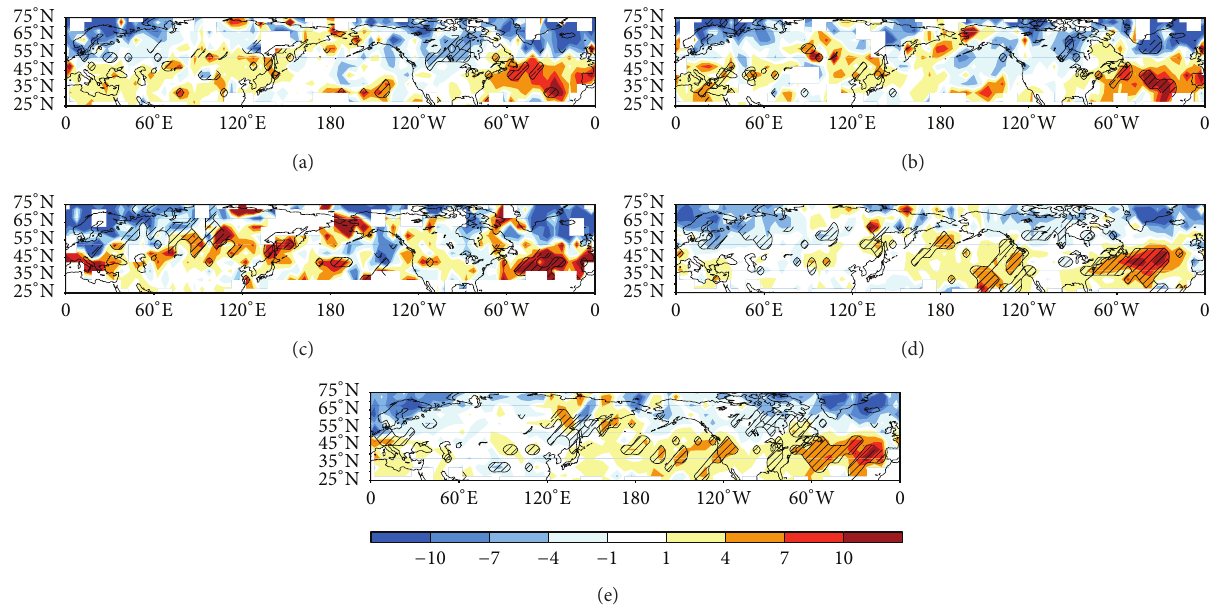
Figure 10: NH storm track intensity composite (hPa) in JFM for (a) NAO positive relative to NAO negative (shaded) 95% significance (hatched) for (a) NCEP1, (b) like (a) but for ERA40, (c) like (a) but for CFSR, (d) like (a) but for CMIP1, and (e) like (a) but for CMIP2.